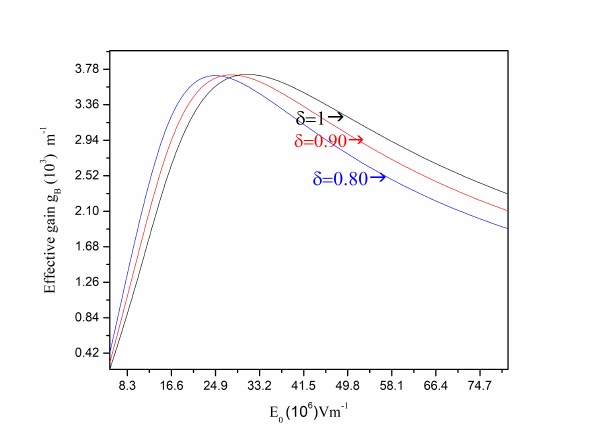
(cid:2) (cid:3) g ef f . with pump electric field E 0 at k 0 = 5 × 10 7 m − 1 and n 0 = 10 26 m − 1 ao